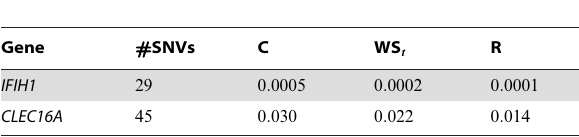
Table 5. Type-1 diabetes